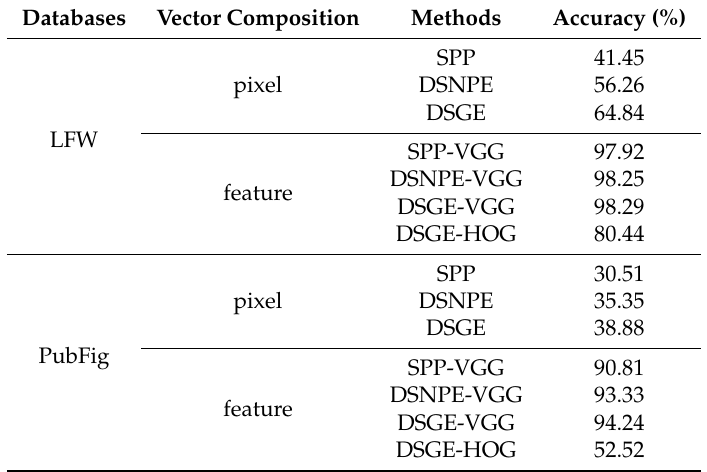
embedding methods on the LFW and PubFig